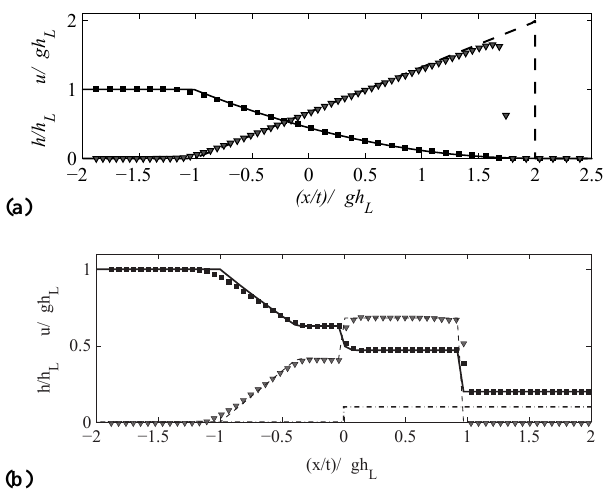
Fig. 3. Stoker solution with corresponding numerical